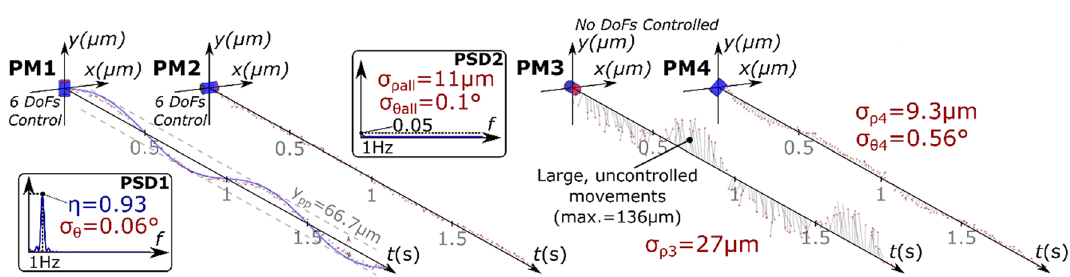
Figure 6. Temporal evolution of the poses of all magnets in a representative 12-DoF control configuration (Group III). A 6-DoF control was employed for PM1 and PM2. PM1 was vibrated along y at 1 Hz, and PM2 was kept still. PM3 and PM4 were left uncontrolled by the MFC. The initial orientation of each magnet is presented at t = 0. The blue line indicates the desired magnet trajectory. The red circles indicate the actual trajectory, as extracted from the video analysis. σ θ / σ ρ indicate the standard deviation of the torsional/linear displacement and η / γ the corresponding efficiency. Insets: power spectral density of PM1 (PSD1) and PM2